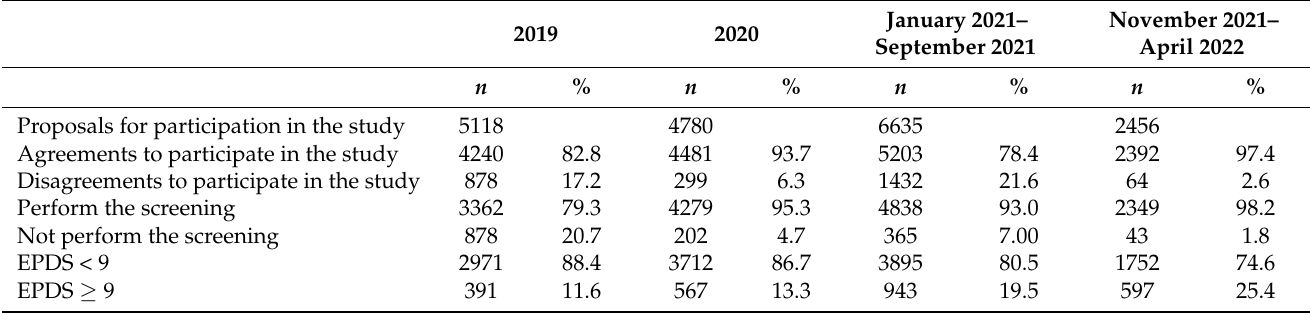
Table 2. Depression screening (EPDS score ≥ 9) in the period 2019–2022.